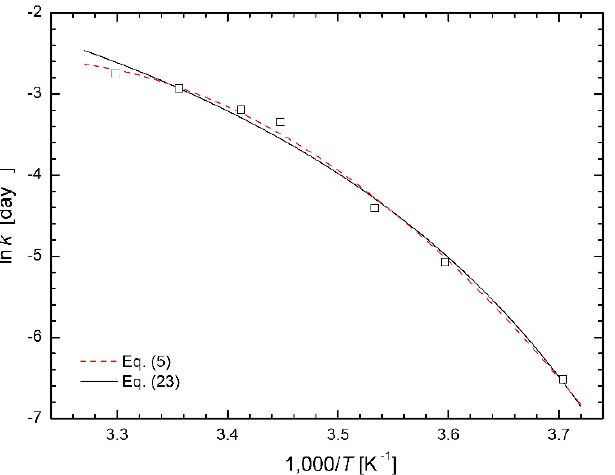
Figure 11. Modified Arrhenius plot for respiration rate of camellia leaves [3] based on Equation (23) is compared with the fit based on Equation (5).